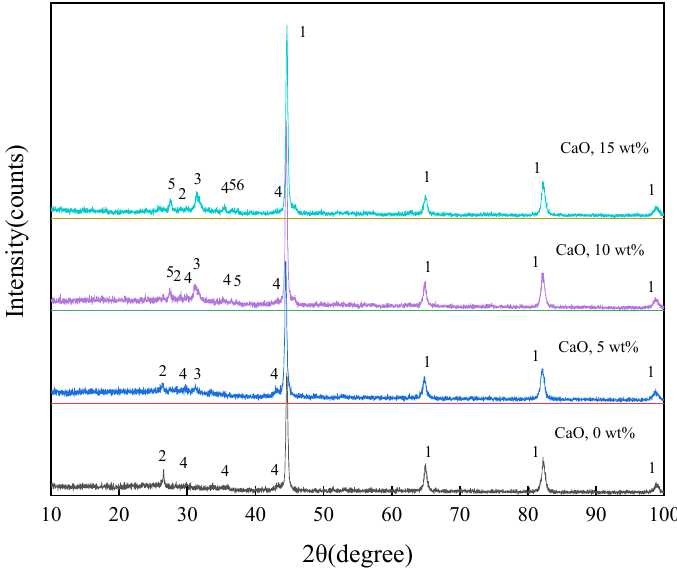
Figure 6. XRD patterns of roasted products under the different added amounts of CaO. 1—Metal iron (Fe); 2—Quartz (SiO 2 ); 3—Oldhamite (CaS); 4—Troilite (FeS); 5—Wollastonite (Ca 3 Si 3 O 9 ); 6—CaO.